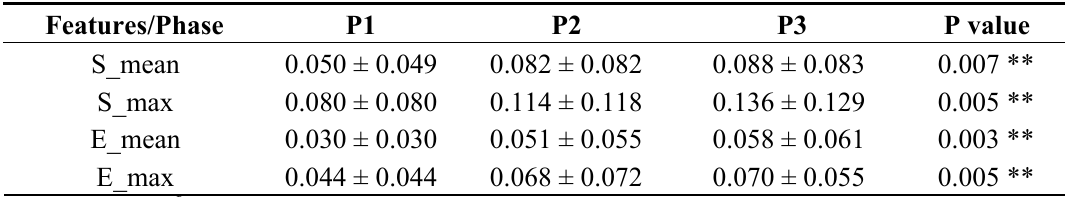
Table 4. Statistical and ANOVA analysis results for three phases. Data is represented as average (standard derivation).